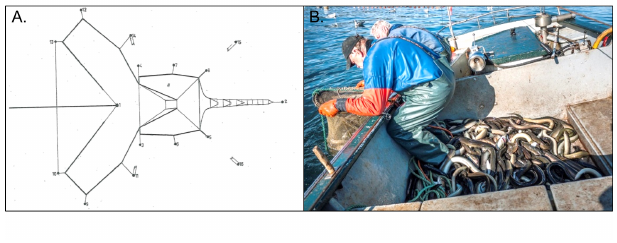
the cone (photo used with the permission of Hans